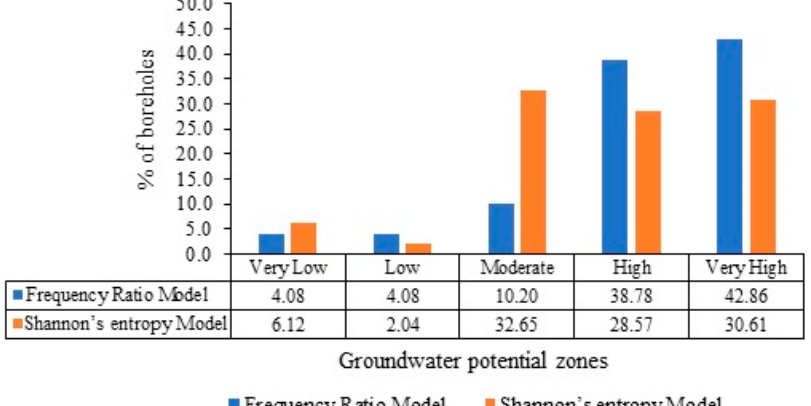
Figure 15. Trend histogram shows the distribution of boreholes at each class of potentialities ob- tained.